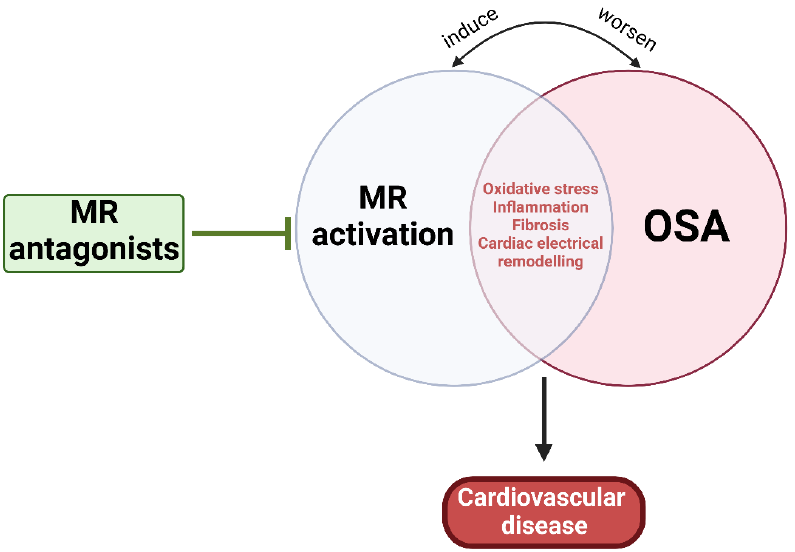
Figure 4. Pathophysiological relationship between OSA and MR activation. MR activation and OSA share multiple mechanisms that can lead to CVD, suggesting the potential benefit of MR an- tagonism.